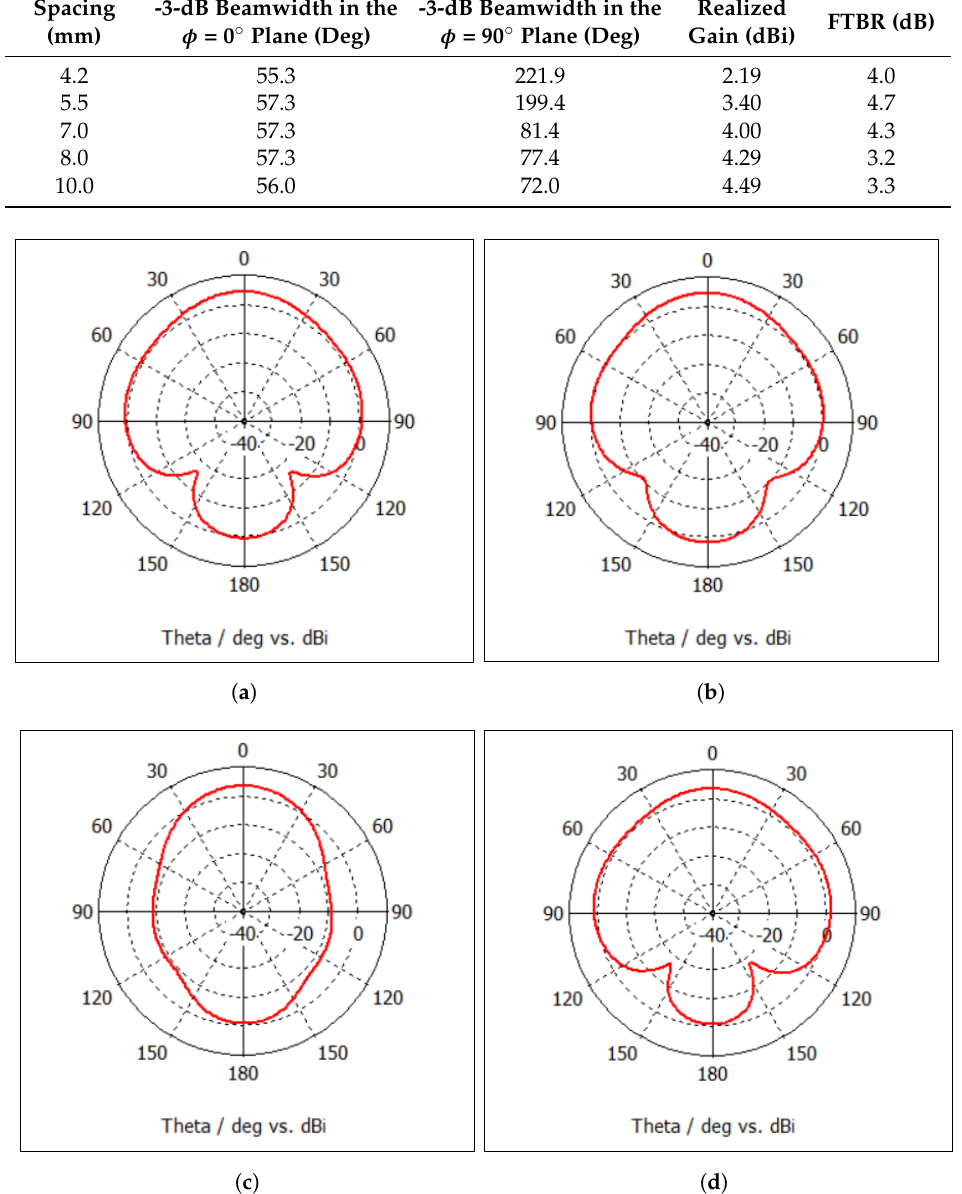
Figure 16. Huygens antenna realized gain patterns at 5.1 GHz for different distances from the metastructure. ( a ) 10 mm spacing, φ = 0 ◦ . ( b ) 10 mm spacing, φ = 90 ◦ . ( c ) 5.5 mm spacing, φ = 0 ◦ . ( d ) 5.5 mm spacing φ = 90 ◦